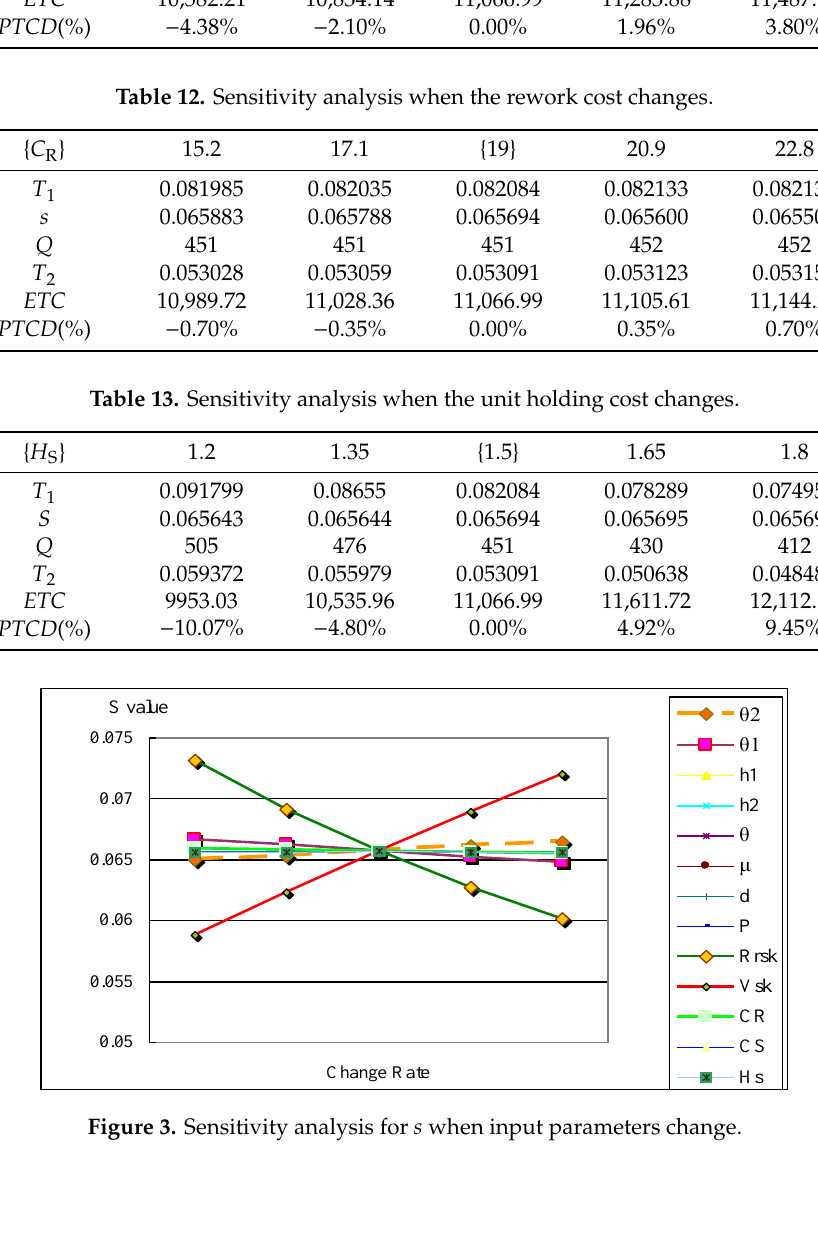
Figure 4. Sensitivity analysis for T 1 when input parameters change. Figure 5. Sensitivity analysis for T 2 when input parameters change.